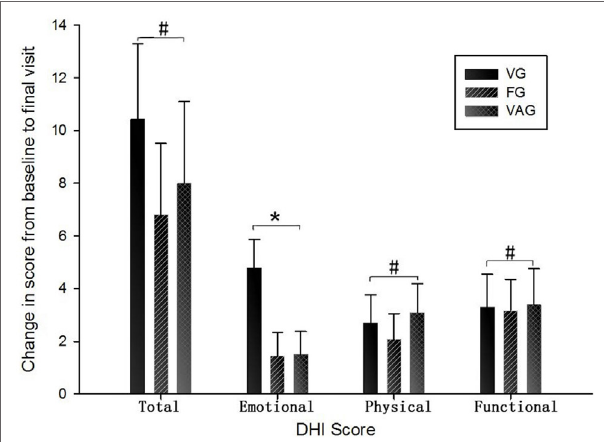
FiGUrE 2 | Change in DHI scores from baseline to final visit for three medications ( )x ± SE . DHI, Dizziness Handicap Inventory; VG, venlafaxine group; FG, flunarizine groups; VAG, valproic acid group ( # p > 0.05; * p < 0.05).